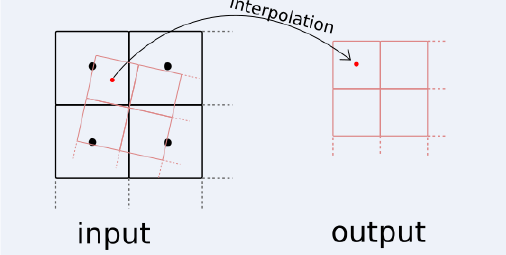
Figure 4. Schematic of the interpolation process (own rep- resentation)